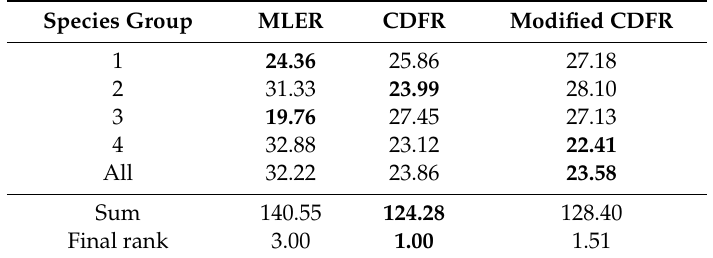
Table 6. Sum of the relative rank a , by species group and fitting